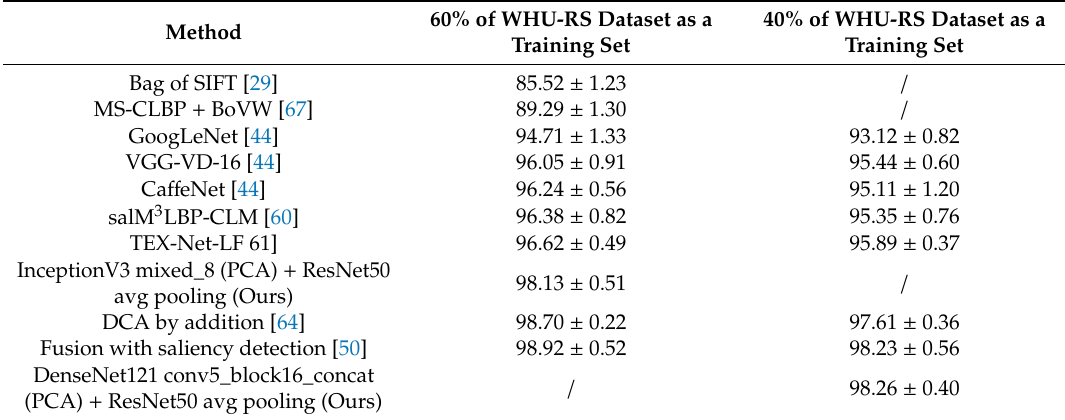
Table 7. The classification accuracy (OA (%) and SD) of the examined method and the reference methods, with 60% and 40% of WHU-RS dataset as a training set.